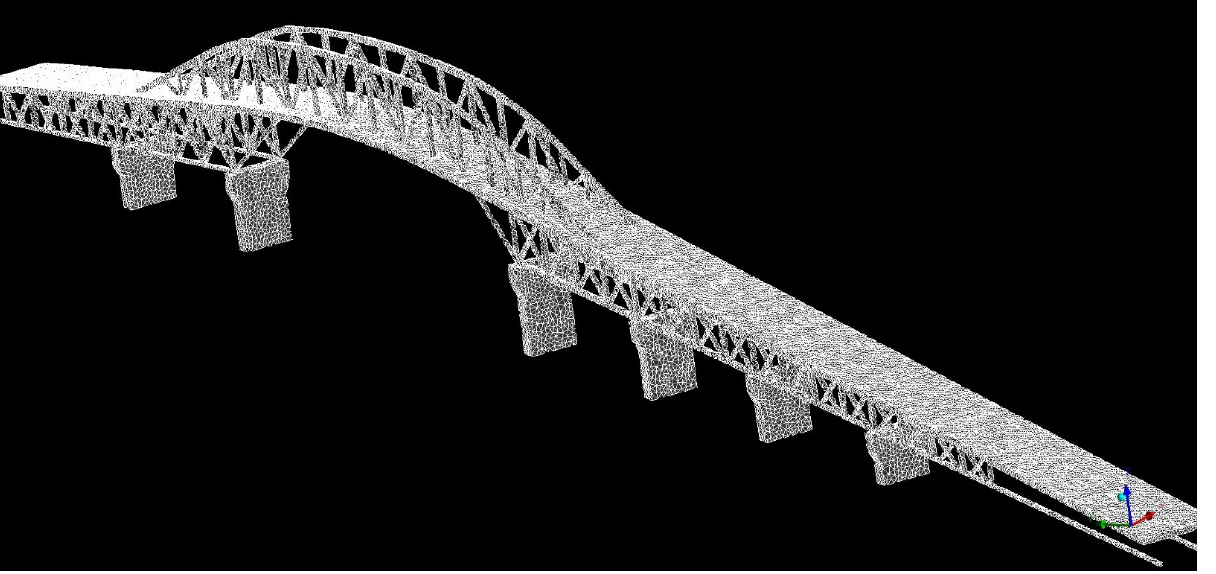
Figure A1. Tetrahedral mesh cells around the bridge with a resolution of 4 m, and even finer down to 0.02 m around the smaller details of the bridge.